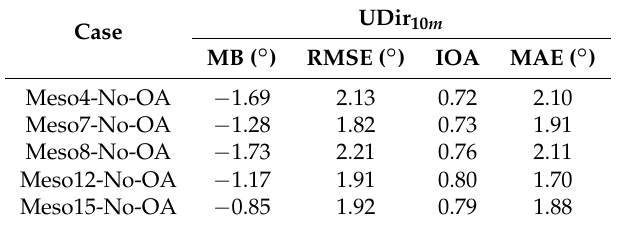
Table A4. Statistical measures for 2-m temperature in mesoscale simulations performed without nudging. Case